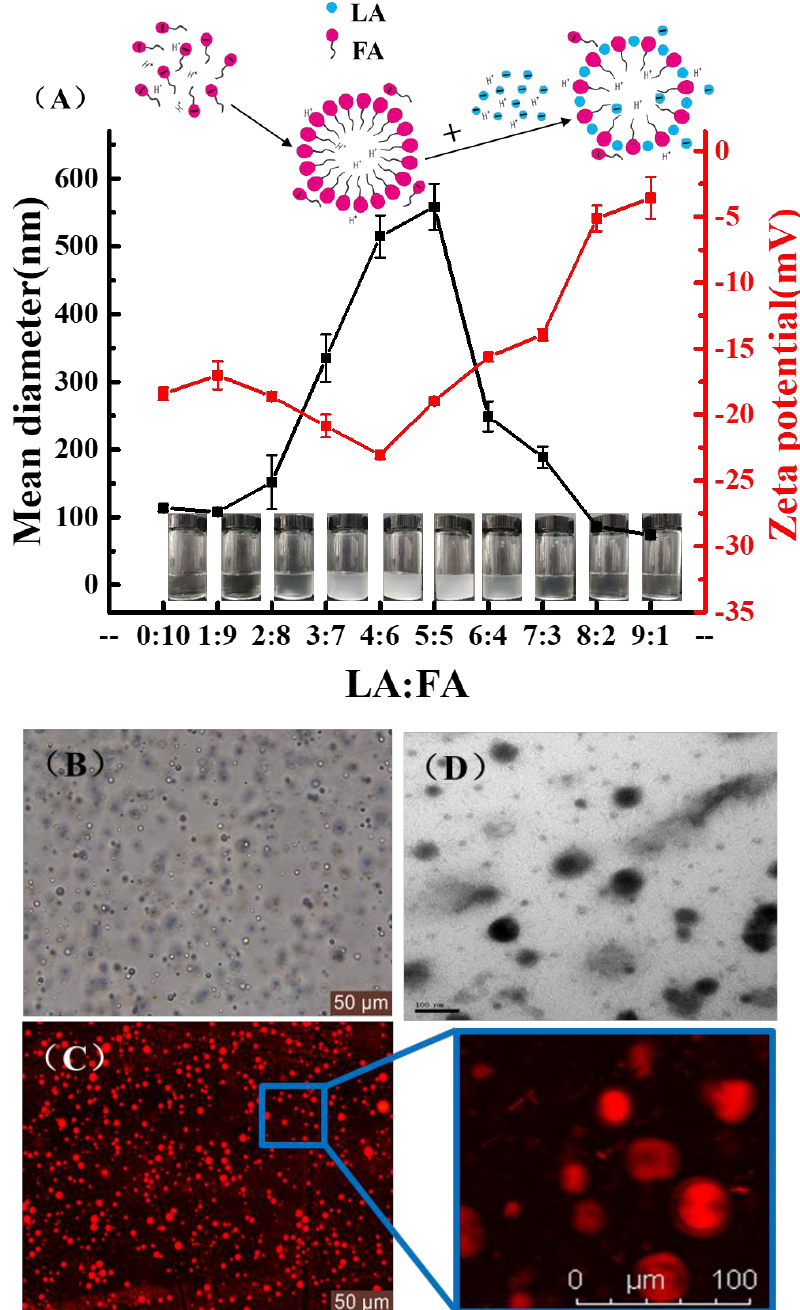
Figure 2. ( A ) The size and zeta-potential of FA vesicles mixed with LA at different molar ratios. ( B ) CLSM microscopic images of homogeneous vesicles were made by LA: FA (1:1) mixture. ( C ) Labeled with 1 mol% RhB. ( D ) The vesicular aggregates by TEM.